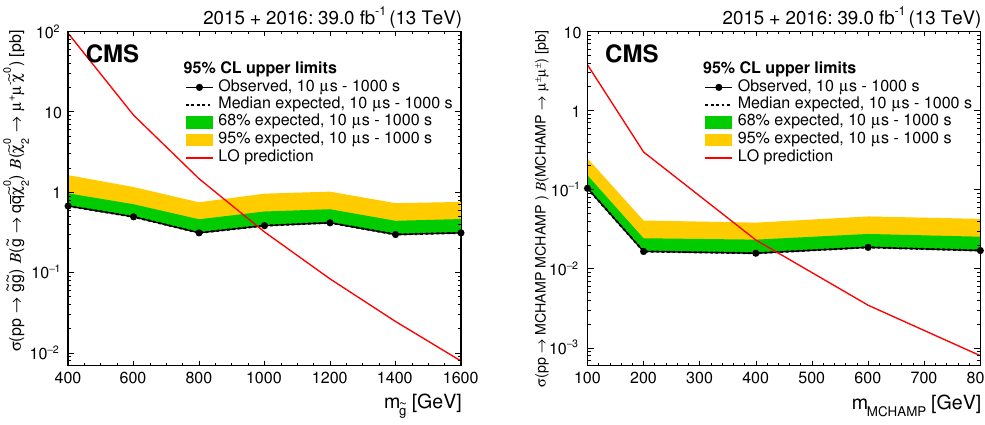
Figure 8 . 95% CL upper limits on B (cid:27) for gluino (left) and MCHAMP (right) pair production as a function of mass, for lifetimes between 10 (cid:22) s and 1000 s, for combined 2015 and 2016 data for the muon search. The theory curves assume B =